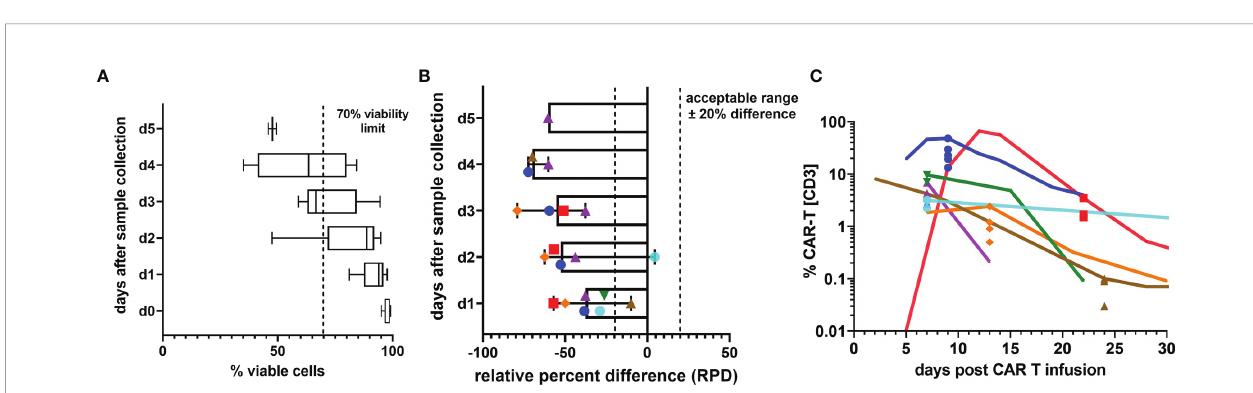
FIGURE 2 | Sample stability. (A) Percentage of 7-AAD - viable white blood cells on the day of specimen collection and up to 5 following days. Box plots indicate median, interquartile range, and minimum and maximum. (B) The relative percent difference (RPD) of the CAR T cell percentage measured on the day of sample collection compared with the CAR T cell percentages on the following days is shown. Due to limited specimen volumes, the number of days on which stability measurements could be performed varied between 2 and 6 days. Each individual patient sample is represented by one symbol and color. Dashed lines mark the limits of acceptable variation. Median RPDs (columns) and range (error bars) are shown. (C) To illustrate the impact of increasing deviations from the d0 value, which is presumed to be the most accurate value, all stability test results are plotted on the respective day of sample collection in the graph and overlayed by the CAR T cell monitoring curves of the patients. The curves run through the d0 value. Colors and symbols match the patients in panel (B)